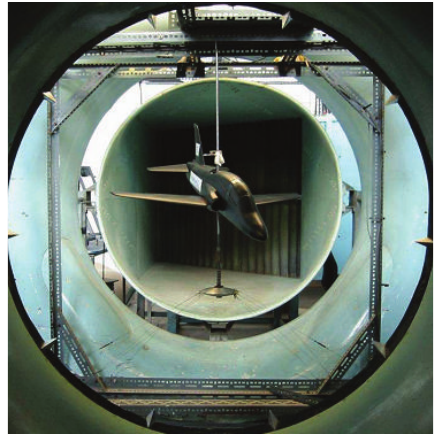
Figure17:Four-degree-of-freedomsupportriginalowspeedopen- section wind tunnel